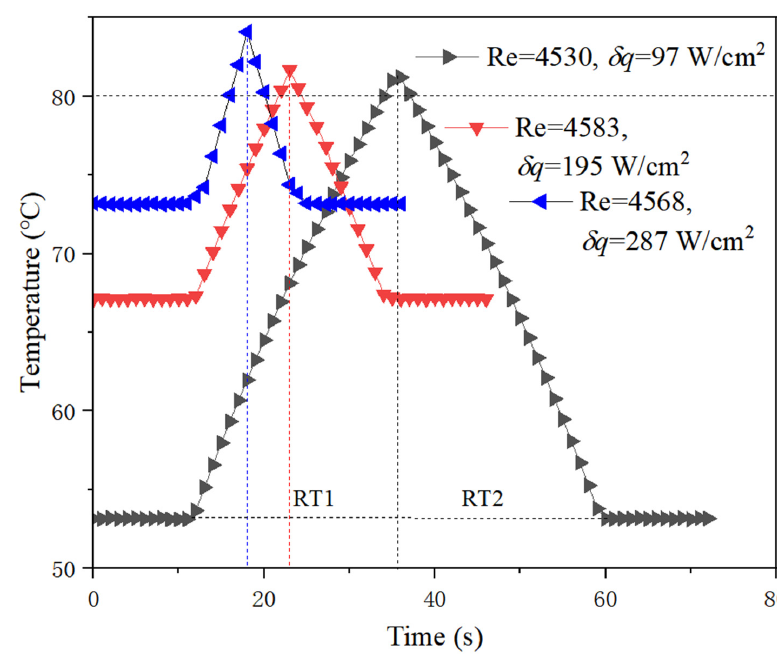
Figure 11. Temperature response characteristics at low flow rate.